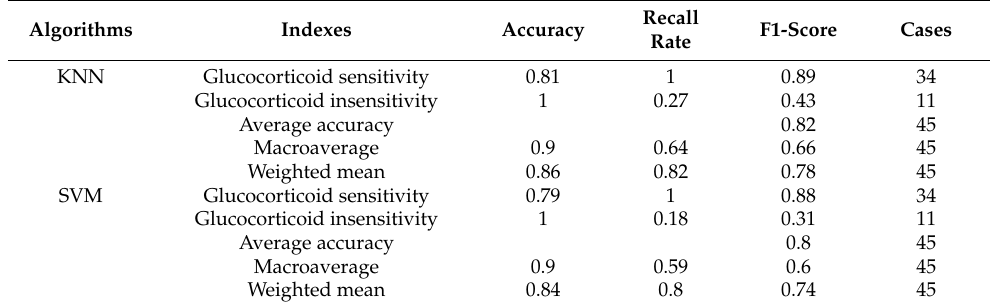
Table 2. Results of the glucocorticoid sensitivity models established using KNN and SVM algorithms.